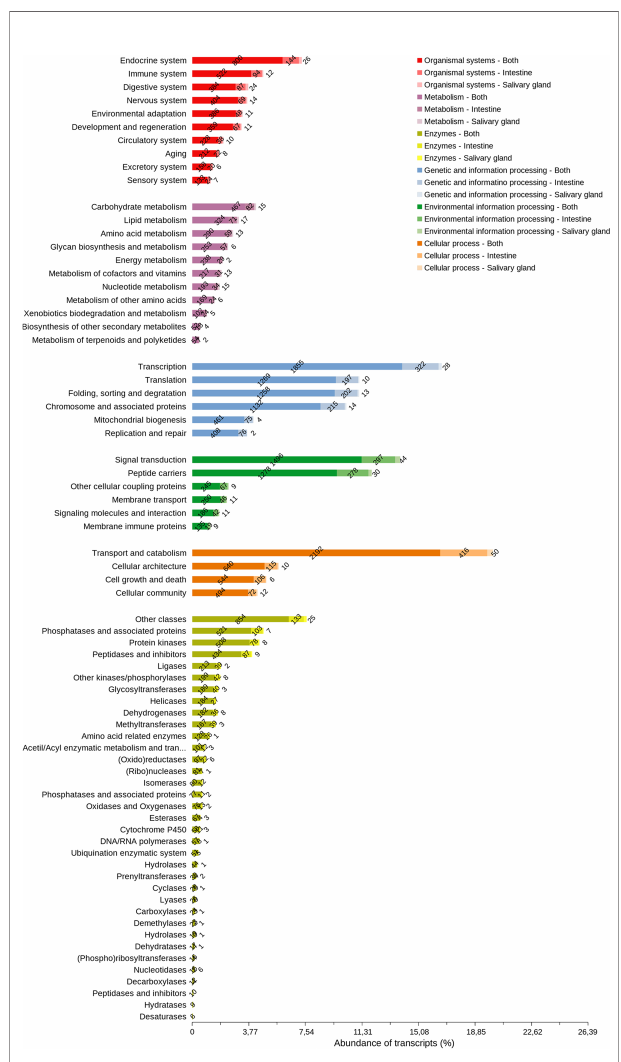
FIGURE 8 | Arthropod orthologous distribution of R. neglectus intestine and salivary gland transcripts according to function. Other cellular coupling proteins: G protein-coupled receptors; Glycosaminoglycan binding proteins; GTP-binding proteins; Nuclear receptors. Peptide carriers: